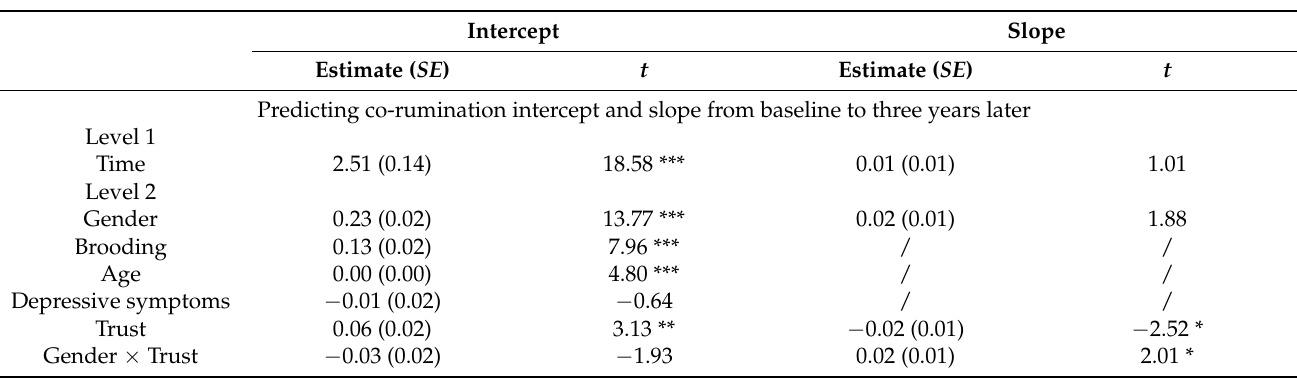
Table 5. Multi-level analyses predicting co-rumination trajectories as a function of the covariates, gender, and trust. Intercept Slope Estimate ( SE ) t Estimate ( SE ) t Predicting co-rumination intercept and slope from baseline to three years